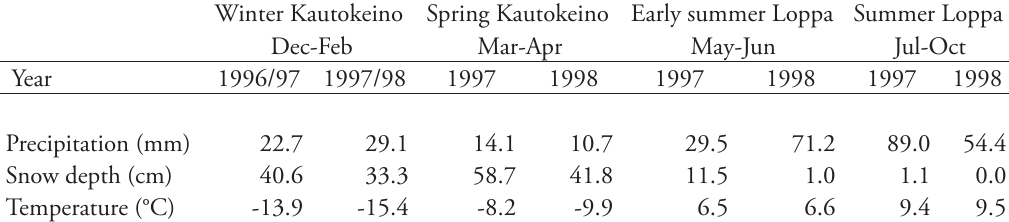
Table 1. Climate variables showing mean values in selected time period at Kautokeino (68.99ºN, 23.03ºE) weather station, reflecting winter and spring conditions, and Loppa (70.33ºN, 21.47ºE ) weather station, reflecting summer conditions.